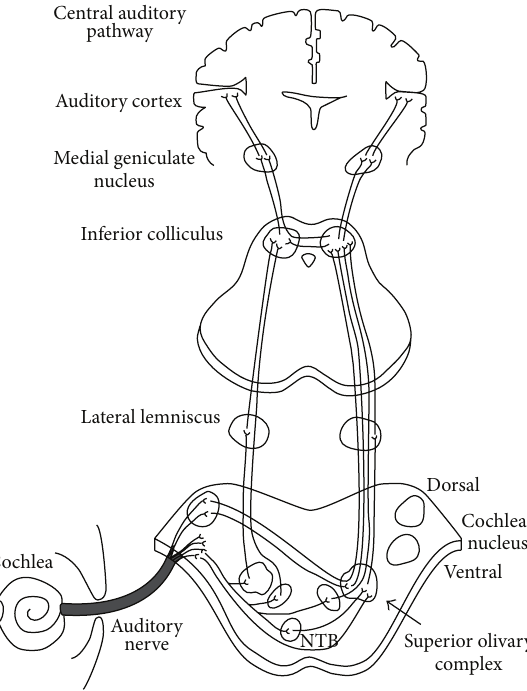
Figure 1: Diagram of the classical auditory pathways from the ear to the auditory cortex (diagram retrieved from https://dnbhelp.word-